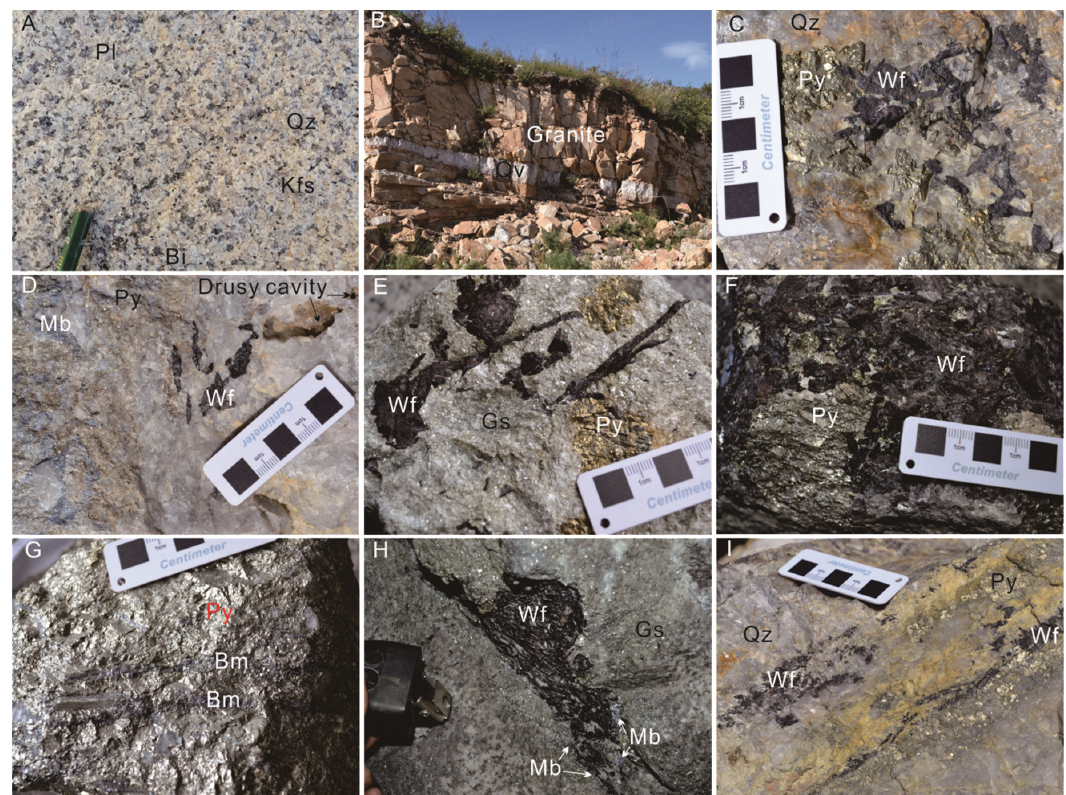
Figure 4. Photographs of the biotite granite ( A ) and the mineralization ( B – I ) in the Baiyinhan deposit showing: ( A ) Biotite granodiorite; ( B ) Wolframite-bearing quartz vein within the granite (dipping to north); ( C ) Quartz + pyrite + wolframite vein; ( D ) Quartz + molybdenite + wolframite vein with drusy cavity; ( E ) Euhedral wolframite in greisen; ( F ) massive ore; ( G ) Bismuthinite in massive ore; ( H ) Veined wolframite in greisen; ( I ) Veined wolframite in quartz vein. Abbreviations: Bi—biotite, Pl—